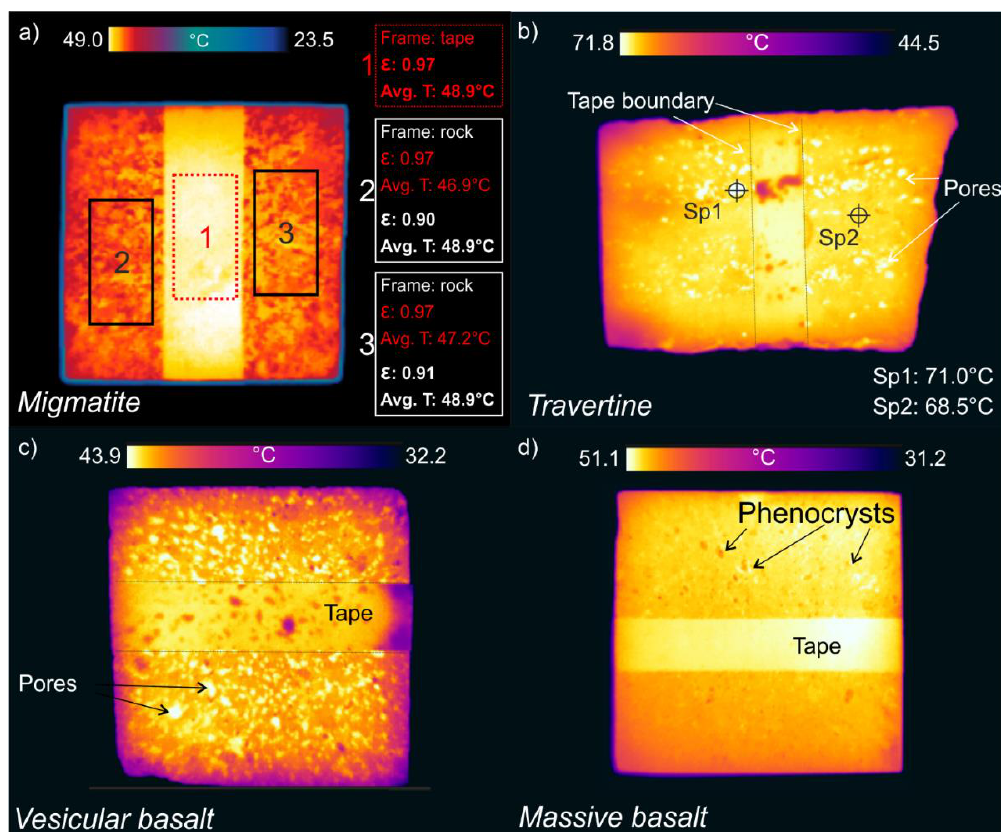
Figure 5. ( a ) Explanatory sketch for the slight emissivity differences occurring within the rocks: a specimen of migmatite characterized by a characteristic emissivity ranging between 0.90 and 0.91; ( b ) pore effect on the surface temperature variation of a travertine sample; ( c ) example of vesicular basalt with voids highlighted by the highest surface temperatures; ( d ) example of massive basalt where no voids affect the specimen surface. In this case, phenocrysts are highlighted by temperature contrast with the